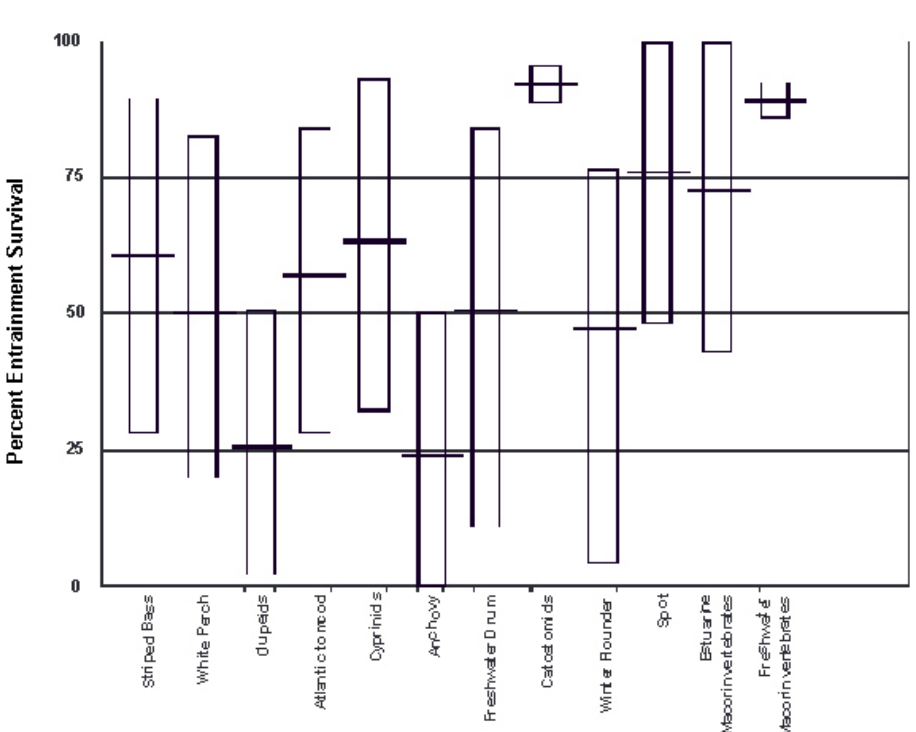
FIGURE 2. An illustration of the range in entrainment survival observed across various groups of fish (Source: EPRI 2000, Figure